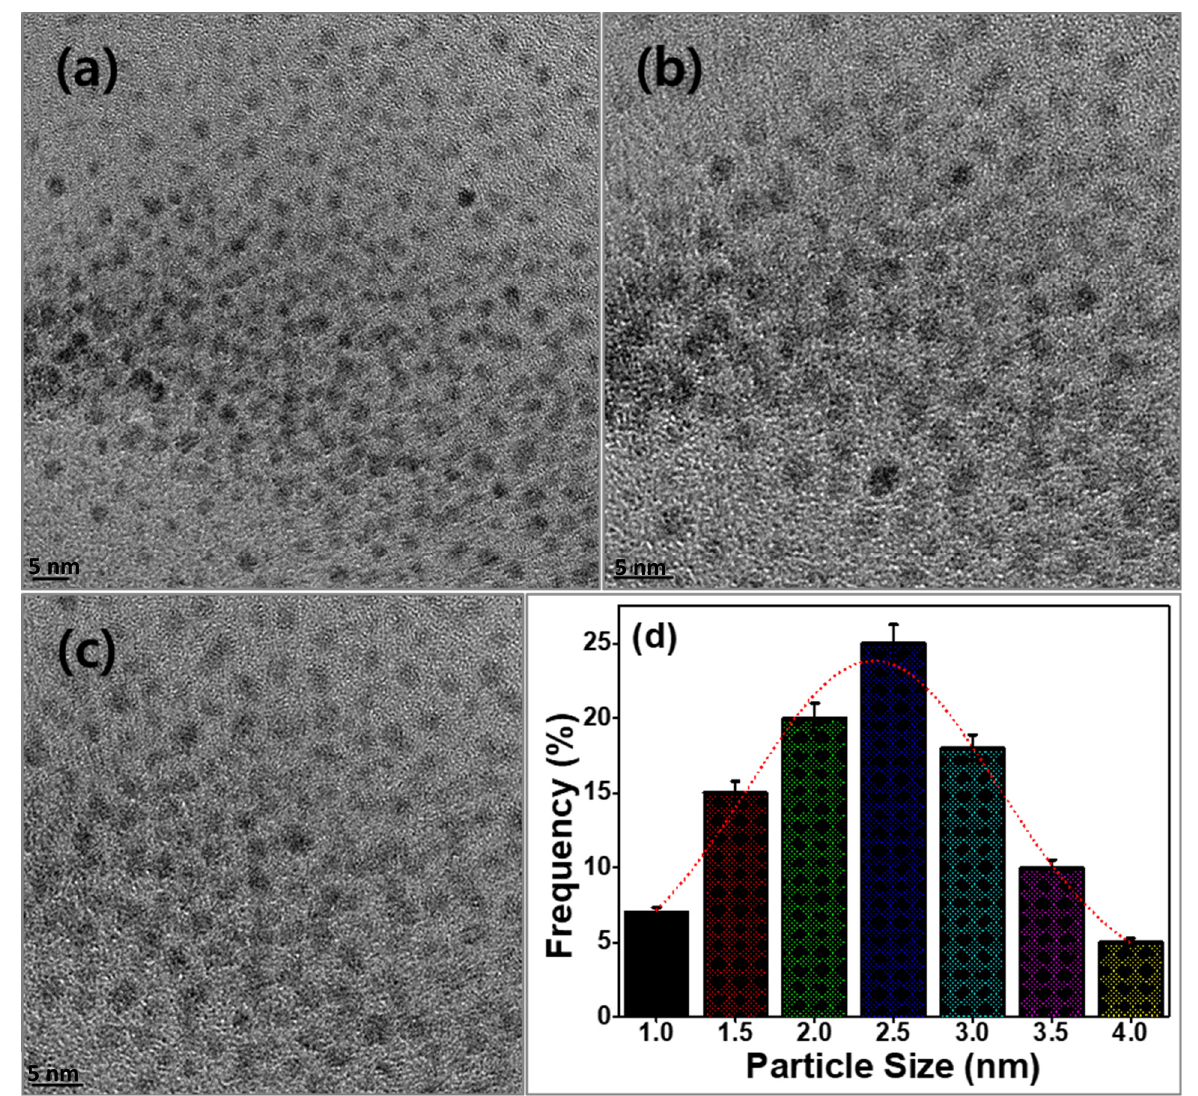
Figure 2. ( a – c ) HRTEM images with different magnifications and ( d ) the corresponding particle-size histogram of the synthesized TC-CDs.